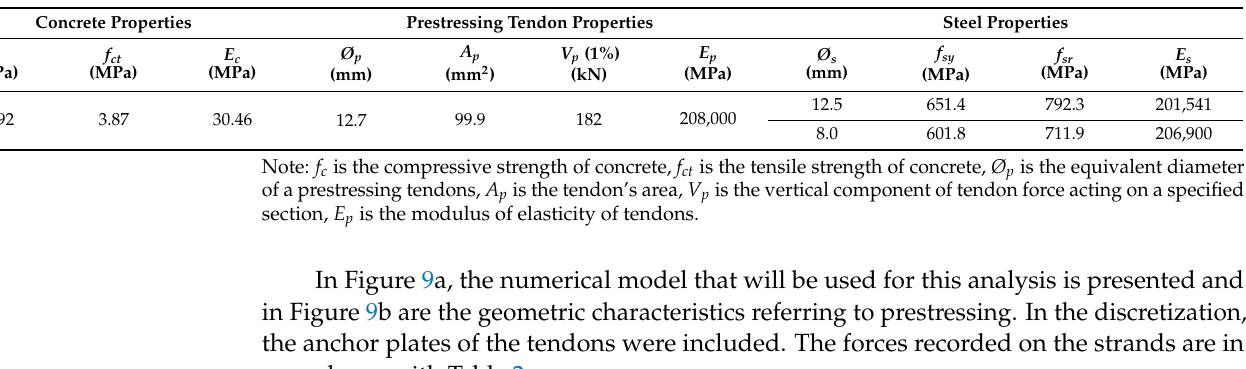
Table 1. Mechanical properties of materials, model M4 [1].